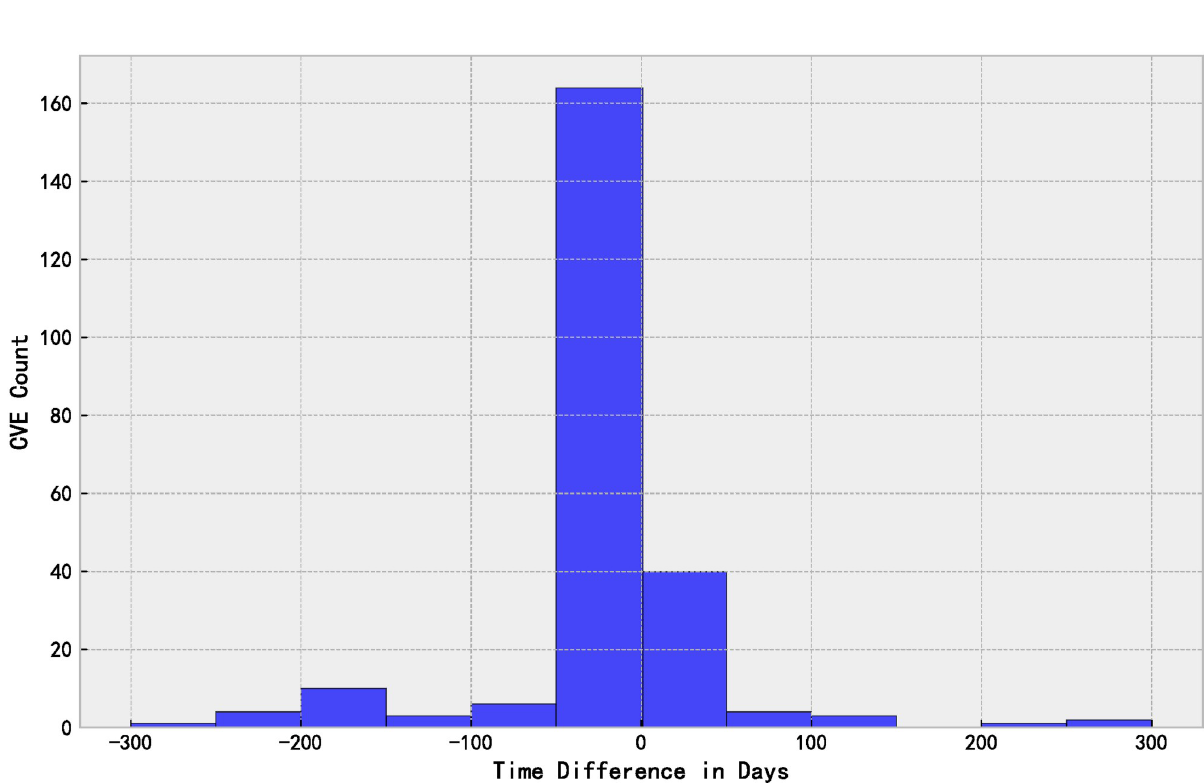
Fig 11. Distribution of the difference in days between vulnerability disclosure and exploit publication.